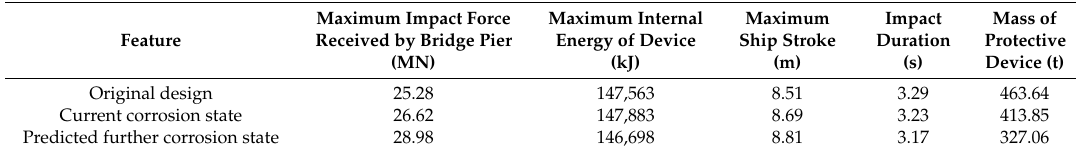
Table 11. Simulation results of bridge pier under different corrosion